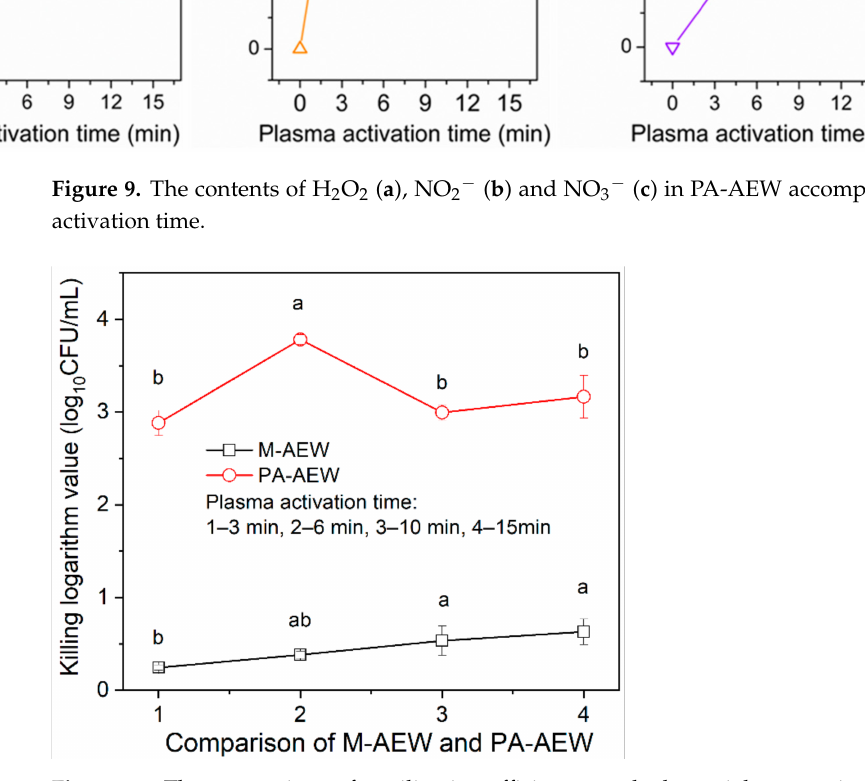
Figure 10. The comparison of sterilization efficiency on the bacterial suspension of B. subtilis for M-AEW and PA-AEW. Values with different lowercase letters above graph bars represent a significant difference ( p <